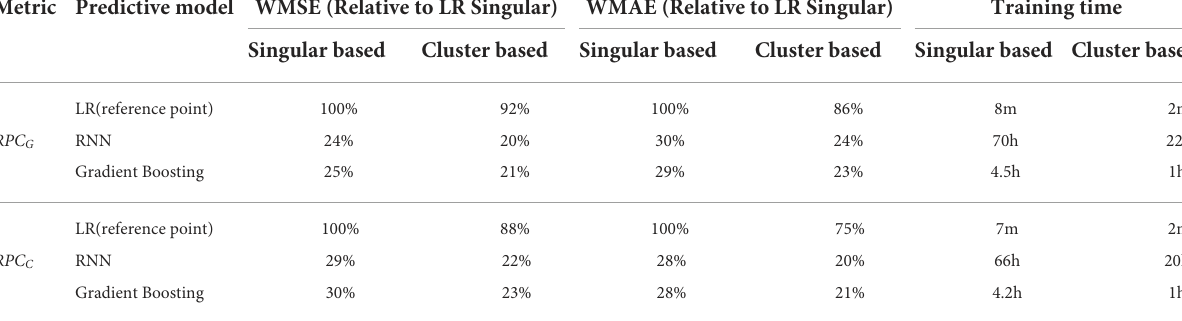
TABLE 5 The RPC G and RPC C predictions accuracy (relative to LR on singular-ad setting), and the offline model training time. Metric Predictive model WMSE (Relative to LR